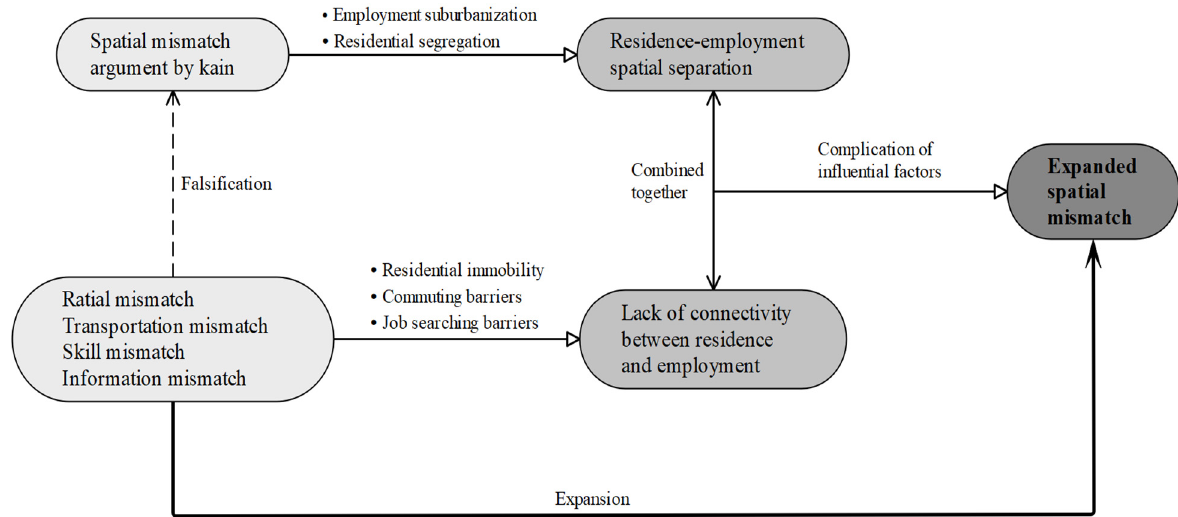
Figure 1. The complication of influential factors of spatial mismatch.